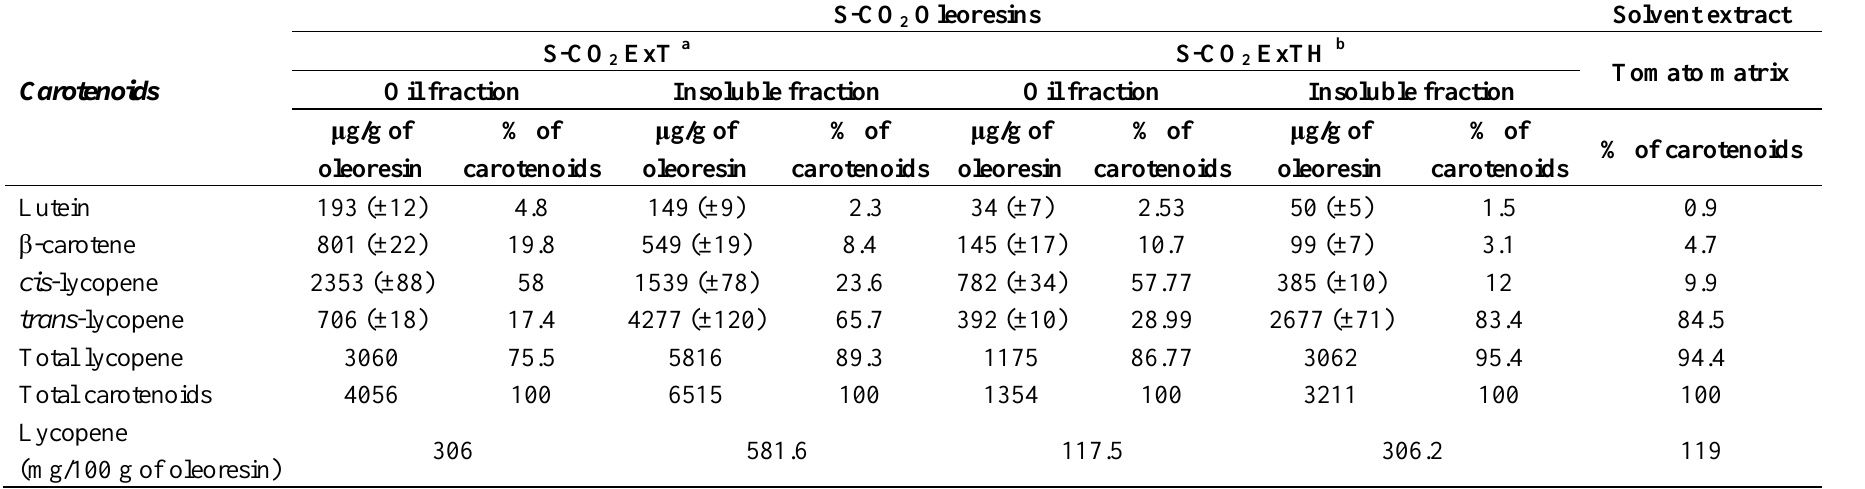
Table 1. Quali-quantitative analysis of carotenoids contained in the oil- and insoluble-fraction of the two S-CO pure tomato powder (S-CO ExT) and from tomato/hazelnut powder (S-CO 2 percentage of the total carotenoids. Data are mean ± SD of three measures from three independent